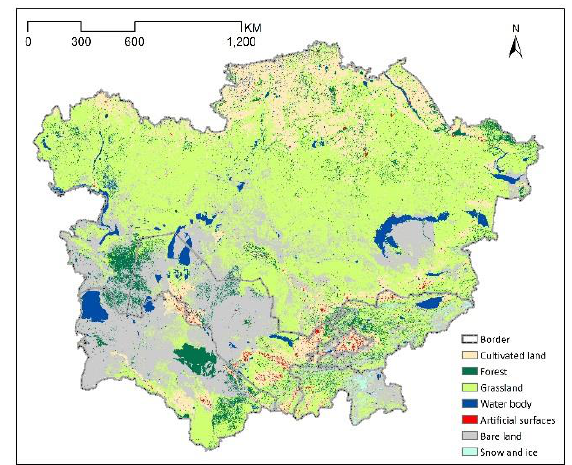
Figure 2. Land cover classification of Central Asia in 2010